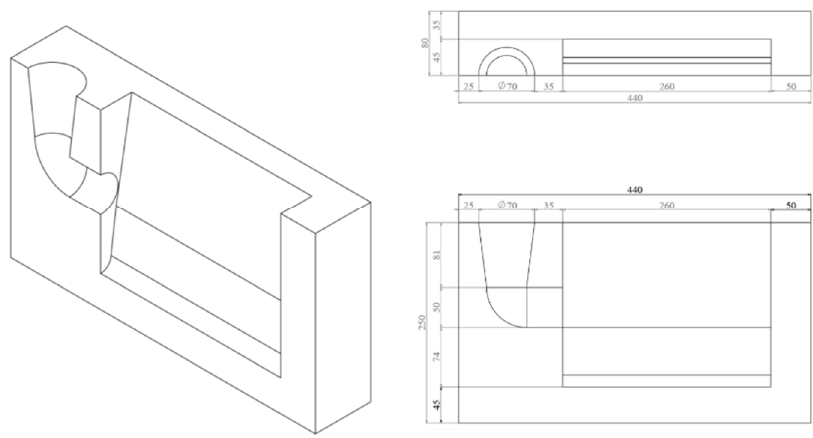
Figure 1. The design of the y-block mould (Unit: mm).